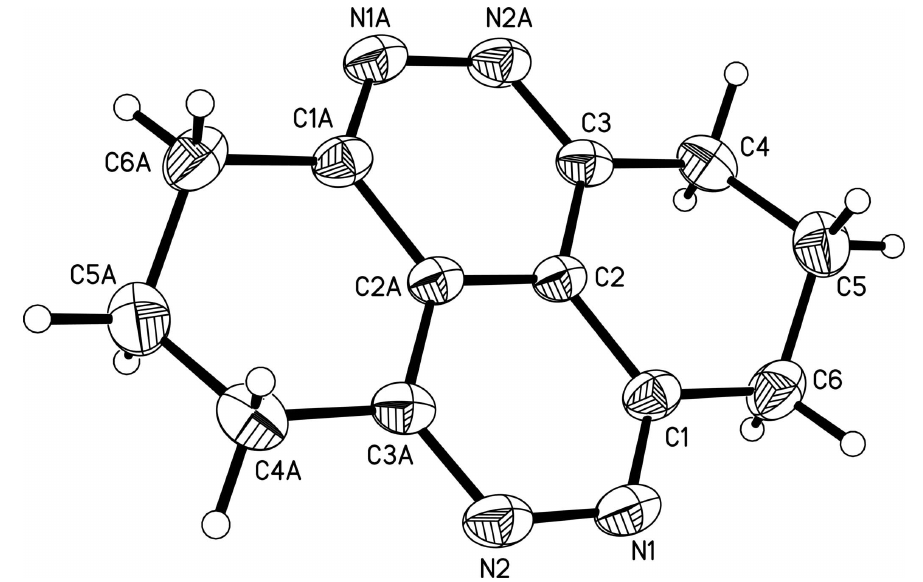
Figure 1 The molecular structure of the title compound, showing 50% probability displacement ellipsoids and the atom-numbering scheme. Atoms labelled with the suffix A are generated by the symmetry operation (1-x, -y,